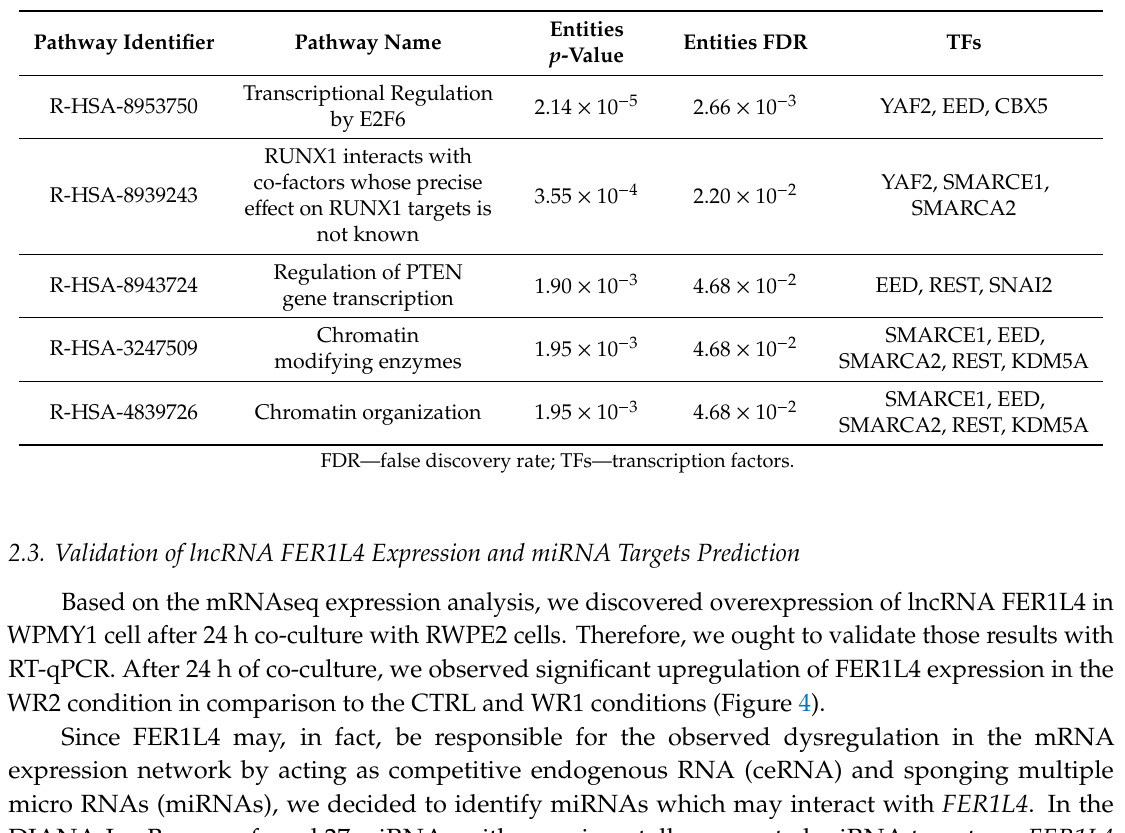
Figure 3. Venn diagram of TFs that changed activity between the 6 and 24 h time points. Table 2. Reactome analysis of unique TFs for 6 vs. 24 h time points in the WR2